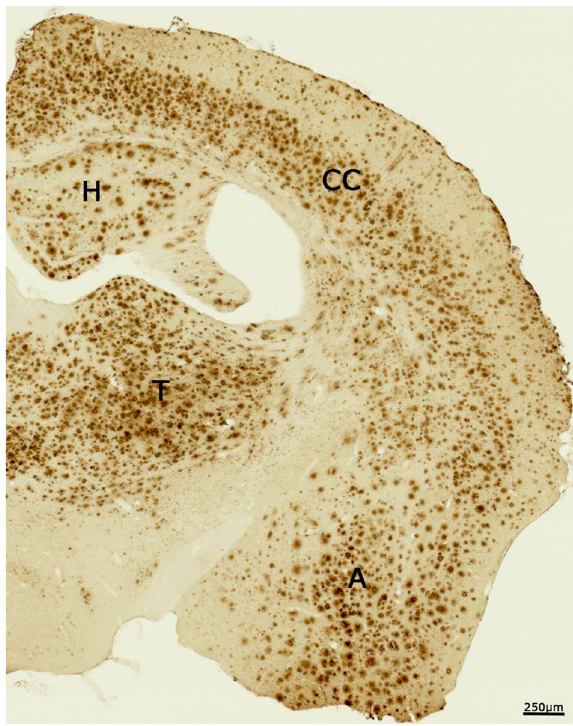
Figure 1. Photomicrograph showing immunohistochemical staining β-amyloid in the brain of the 5XFAD mouse used in this study. There is significant accumulation of β-amyloid plaques in a number of brain regions including the cerebral cortex (CC), hippocampus (H), thalamus (T), and amygdala (A). Scale bar 250 μm.